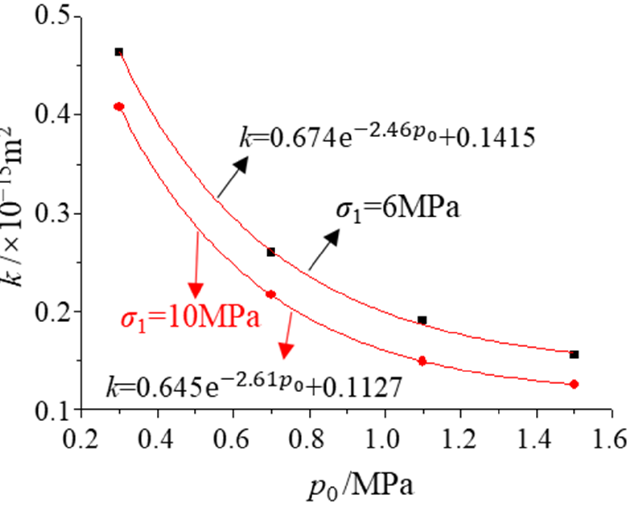
Figure 9. Gas permeability versus initial gas pressure curves at axial pressures of 6 and 10 MPa.